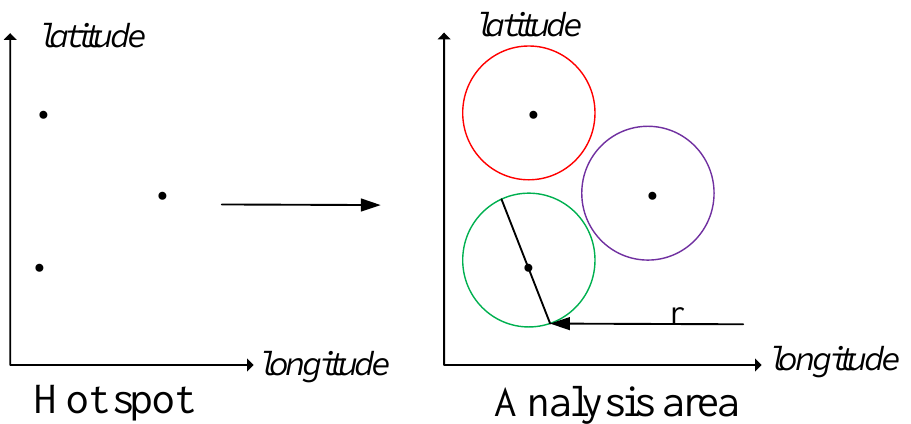
Figure 2. The flowchart of hotspot detection.